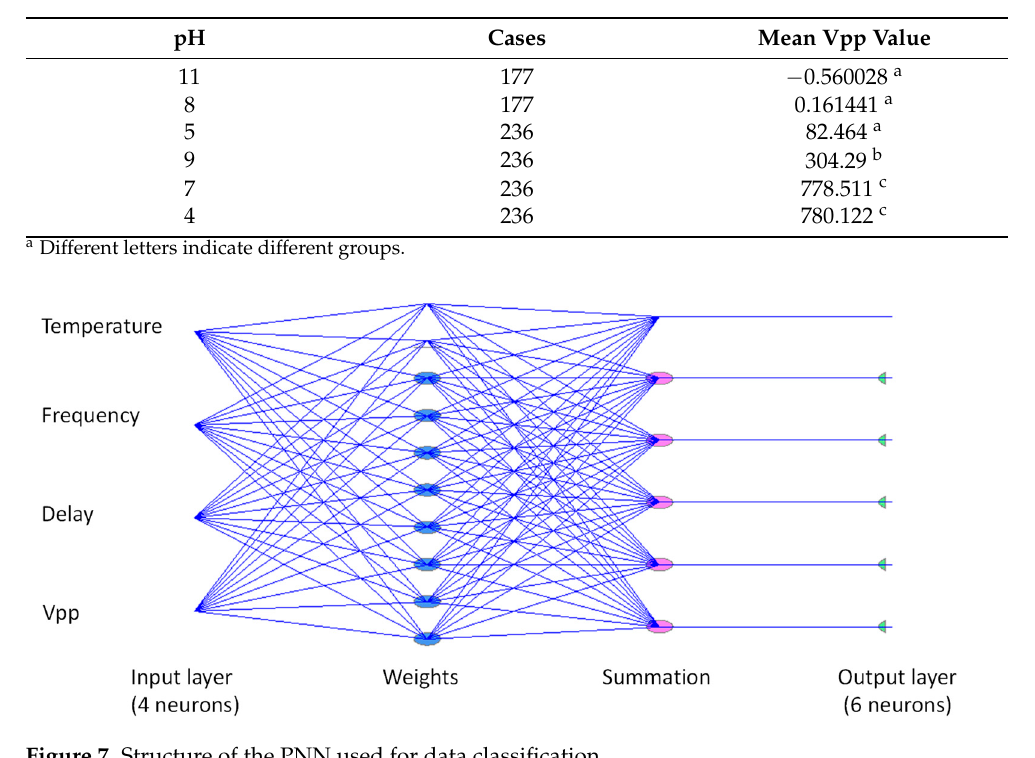
Table 10. Classification results of PNN using all cases and temperature, Vpp, and delay as input neurons. Current pH Cases